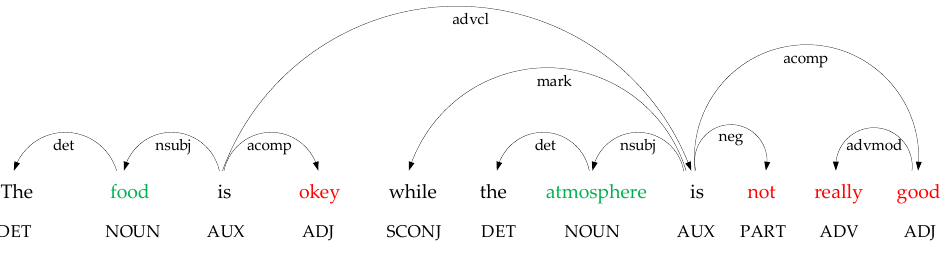
Figure 1. Syntactic dependency tree.